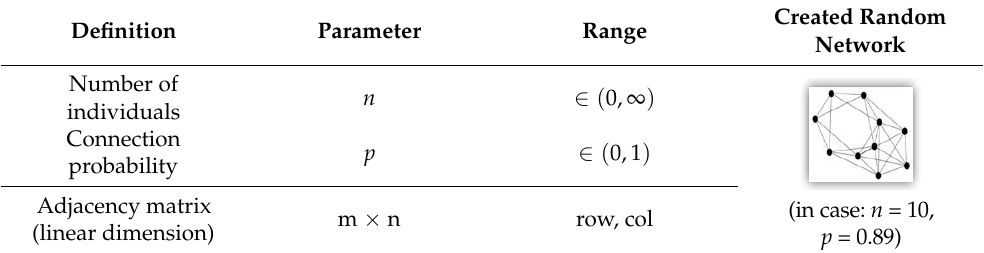
Table 8. Created network characteristics of parameter values. Table 8. C reated network characteristics of parameter values.